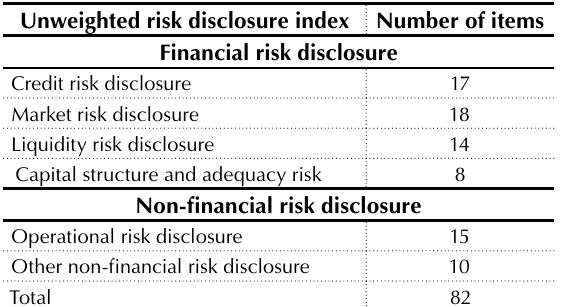
Table 1. Risk disclosure